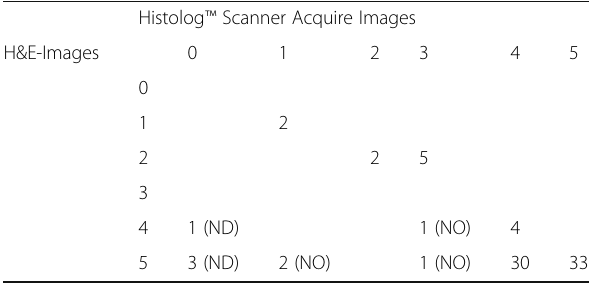
Table 1 Results: B-classification of Confocal scanner images compared to B-classification of H&E images Histolog ™ Scanner Acquire Images